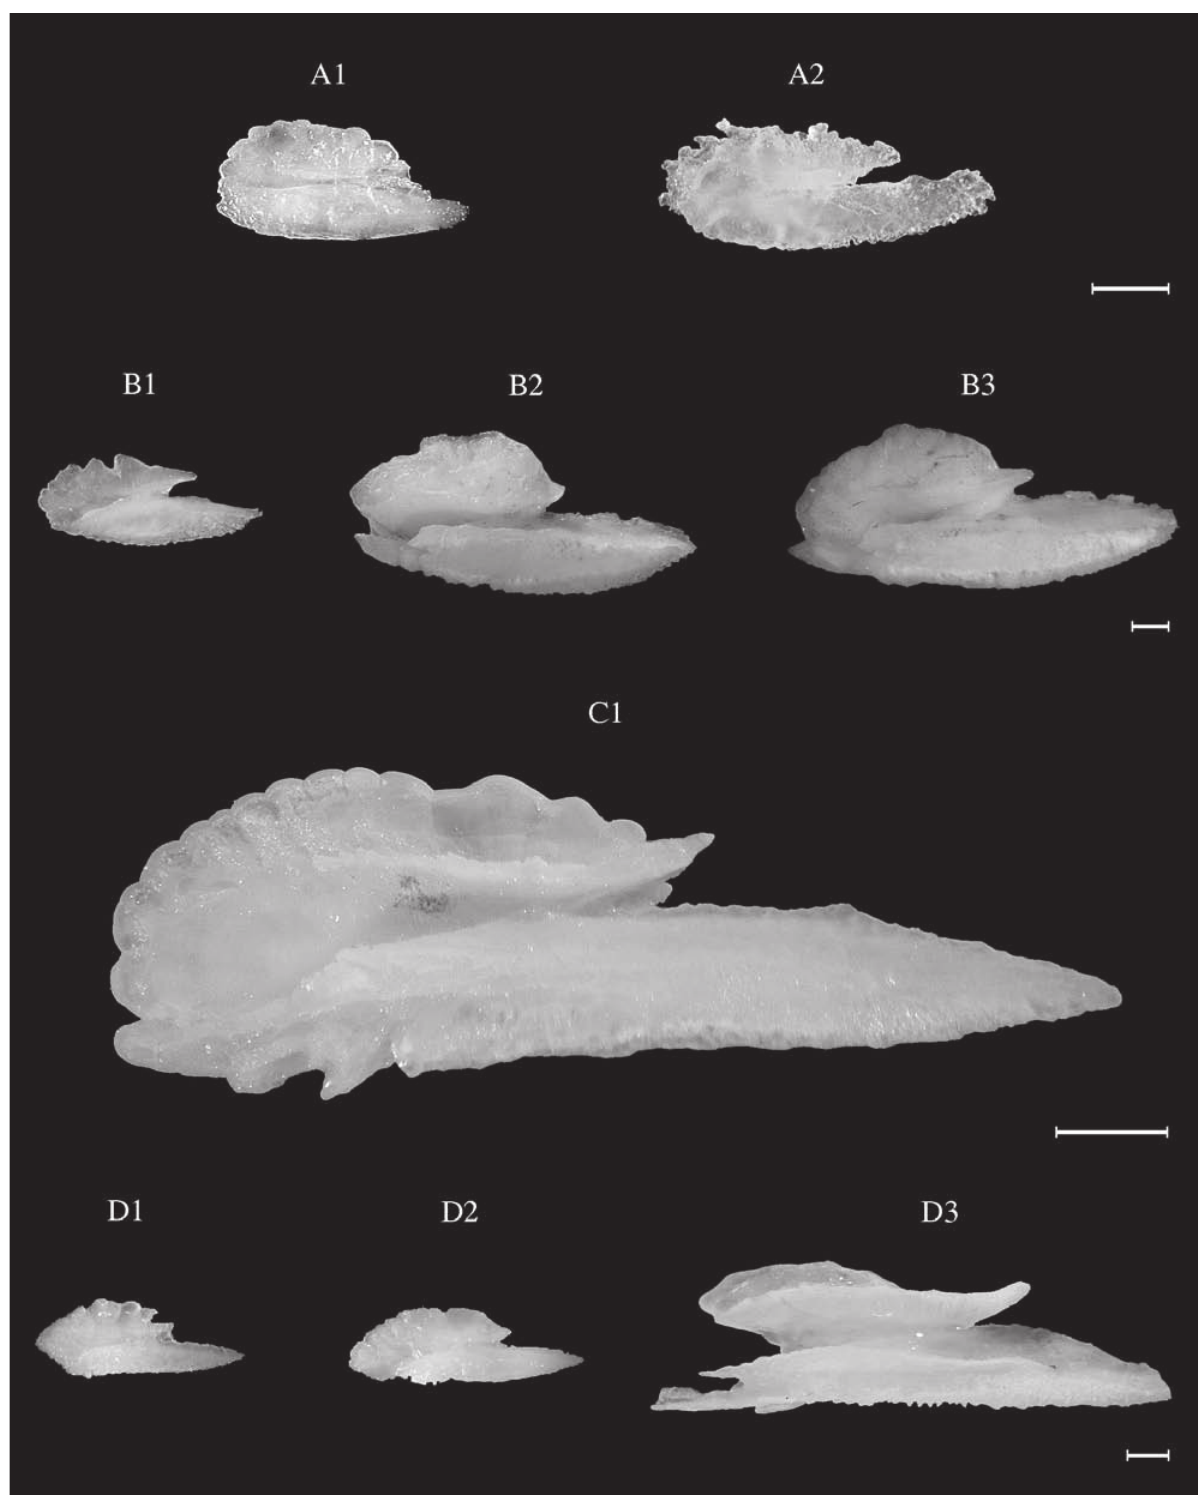
Fig. 52. – Lichia amia (WM). TL: A1, 28.5 cm; A2, 143.0 cm. Pseudocaranx dentex (CEA). TL: B1, 32.0 cm; B2, 57.2 cm; B3, 62.7 cm. Seriola carpenteri (CEA). TL: C1, 91.6 cm. Seriola dumerili . TL: D1, 33.5 cm (WM); D2, 37.5 cm (WM); D3, 155.0 cm (CEA). Scale bar = 1